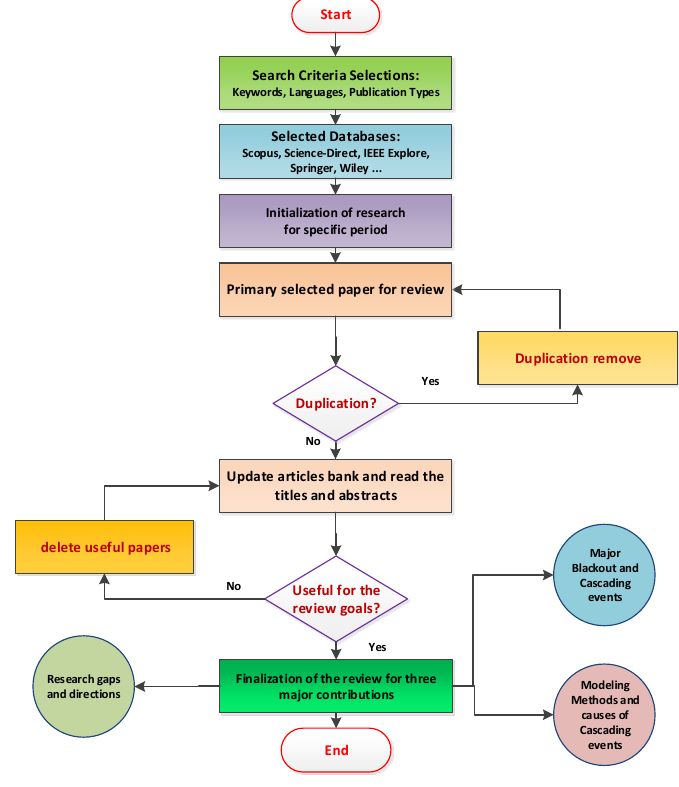
Figure 1. The flowchart of the review methodology